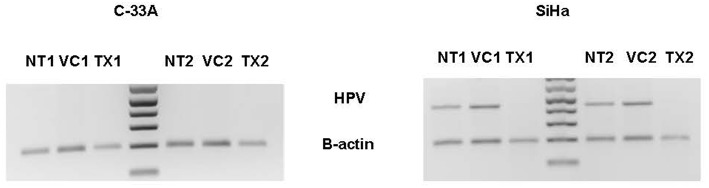
There were three arms in the animal study: AHCC supplementation arm (N = 10), no supplementation control arm (N = 10) and a vehicle (autoclaved water) control arm (N = 10). The AHCC supplementation arm received an oral dose (50 mg/kg, in 0.25 mL, gastric gavage); the no supplementation control had no study intervention, and the vehicle control arm received an oral dose of autoclaved water (0.25 mL, gastric gavage) per day starting on day zero and continued until completion of the study (day 90). TX1 represents at end of treatment and TX2 represents study day 90 which was 30 days after stopping AHCC supplementation. The absence of HR-HPV in the SiHa cell lines at TX1 and TX2 confirmed clearance of HR-HPV. NT, non-treatment control; VC, vehicle/placebo control.